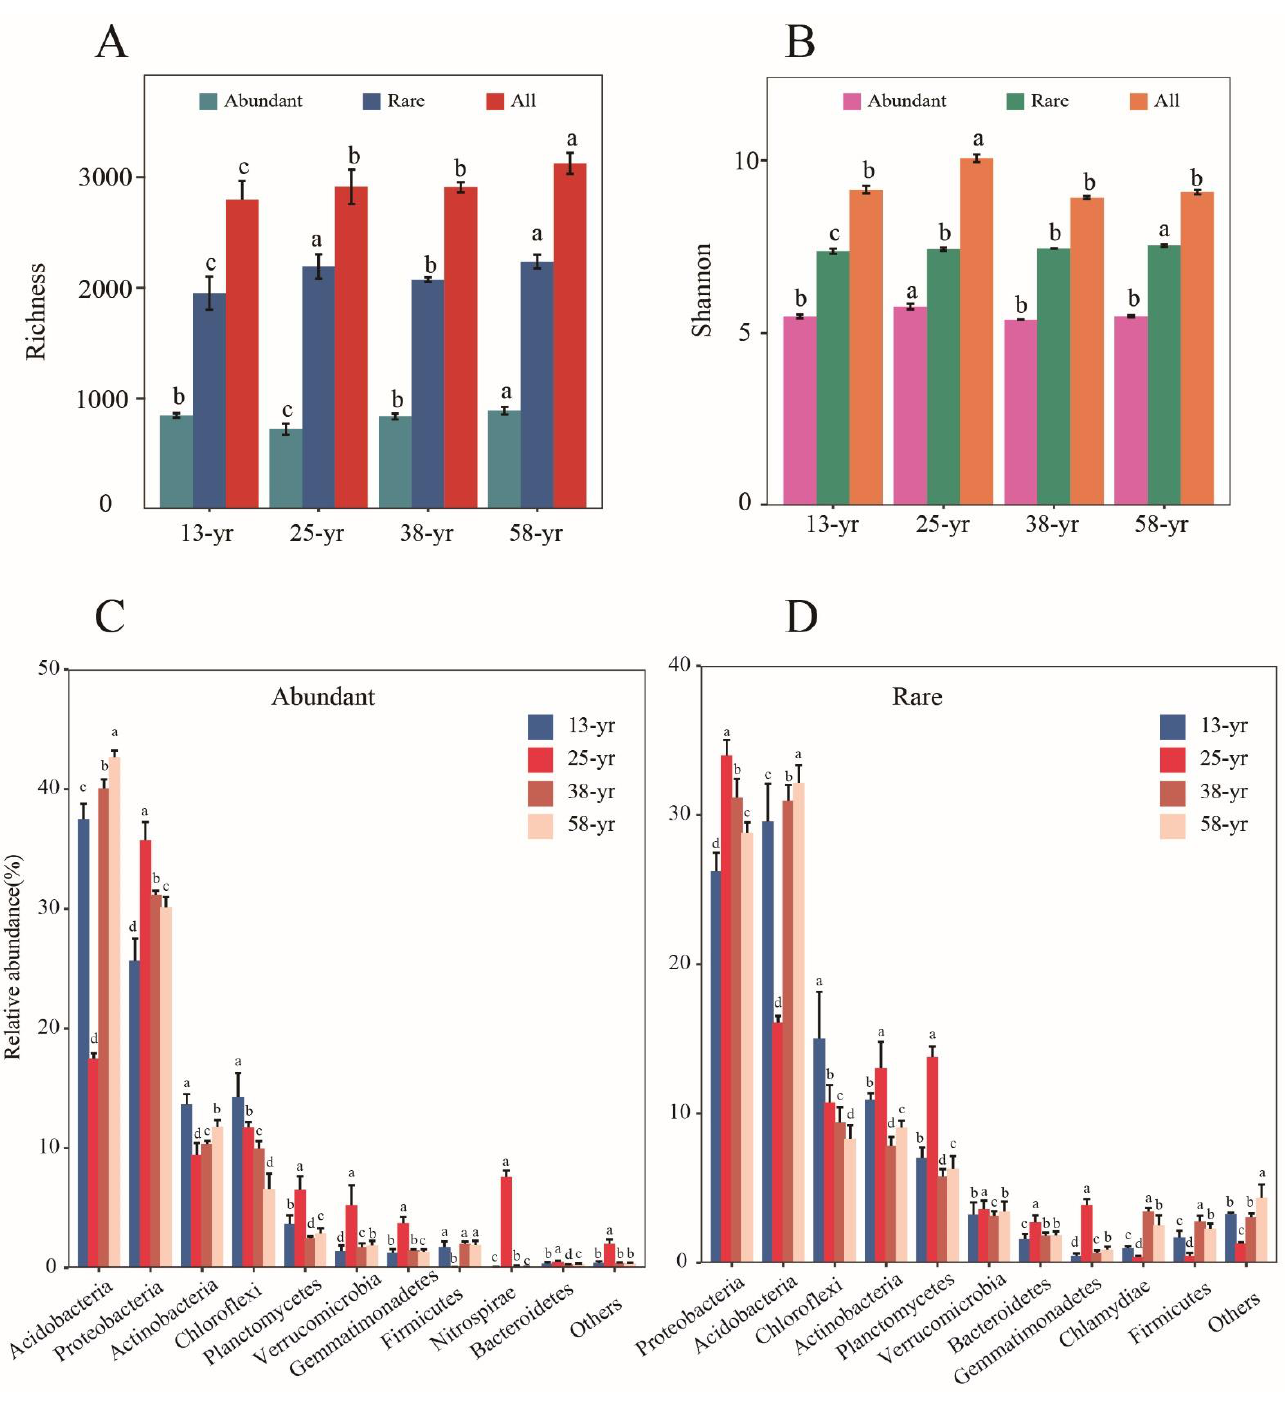
Figure 1. OTU richness and Shannon index of abundant and rare bacterial community ( A , B ). The relative abundance changes in the top 10 abundant phyla in the abundant and rare taxa across different stand ages ( C , D ). Columns are the mean ± SE (standard error). The same lowercase letters indicate that the same taxa have no difference across P. massoniana stands of different ages.